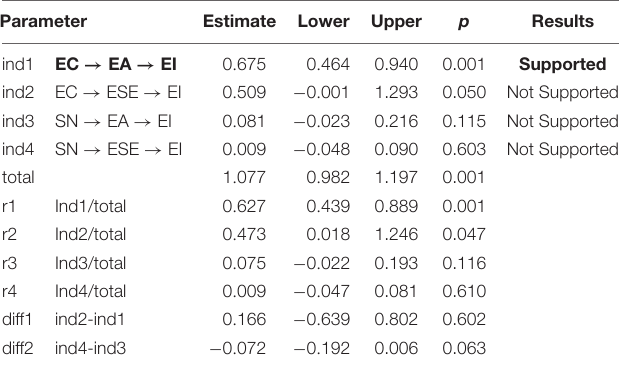
TABLE 6 | The mediating testing result.